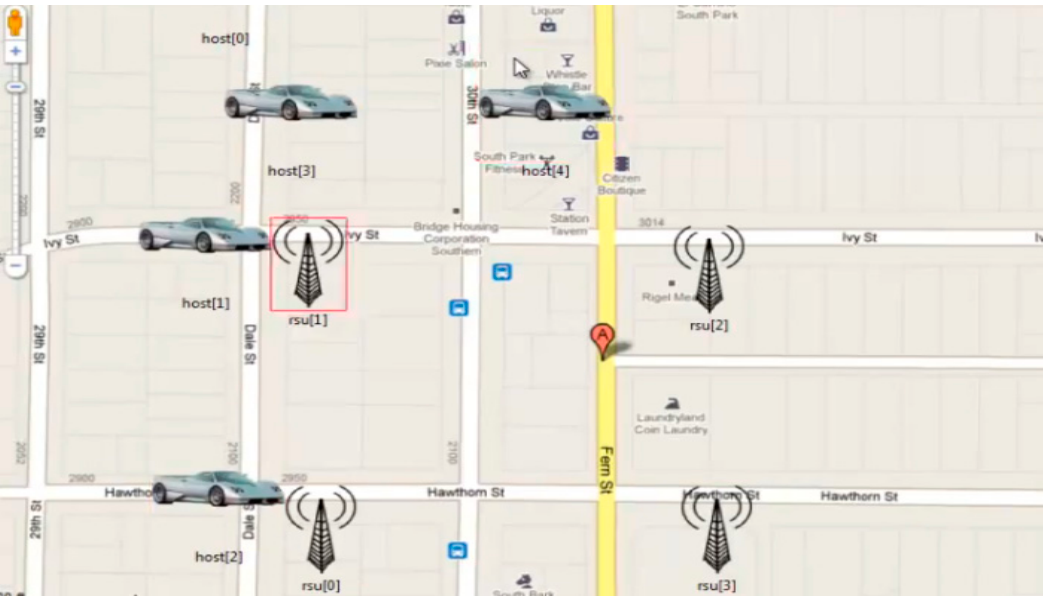
( b ) Figure 7. ( a ) Bandwidth allocation ongoing between the vehicles. ( b ). Bandwidth allocation and message passing between vehicles. The proposed model based on the hashgraph was validated through a simulation on OMNeT++, as well as by fabricating a piece of IoT hardware to synchronize the model during the deployment. OMNeT++ provides a network simulation facility in the form of a modular extensible component- based C++ library. Presented are the results of a basic simulation executed on OMNeT++ pertaining to the gossip protocol of the hashgraph running between the vehicles as shown in Figure 8. The messages transferred are of four types: security messages, help messages, event messages, and multimedia messages. OMNeT++ has an excellent graphic user interface. The components of the simulation, such as initialization, handling, and forwarding of messages, are written in C++. These components, on